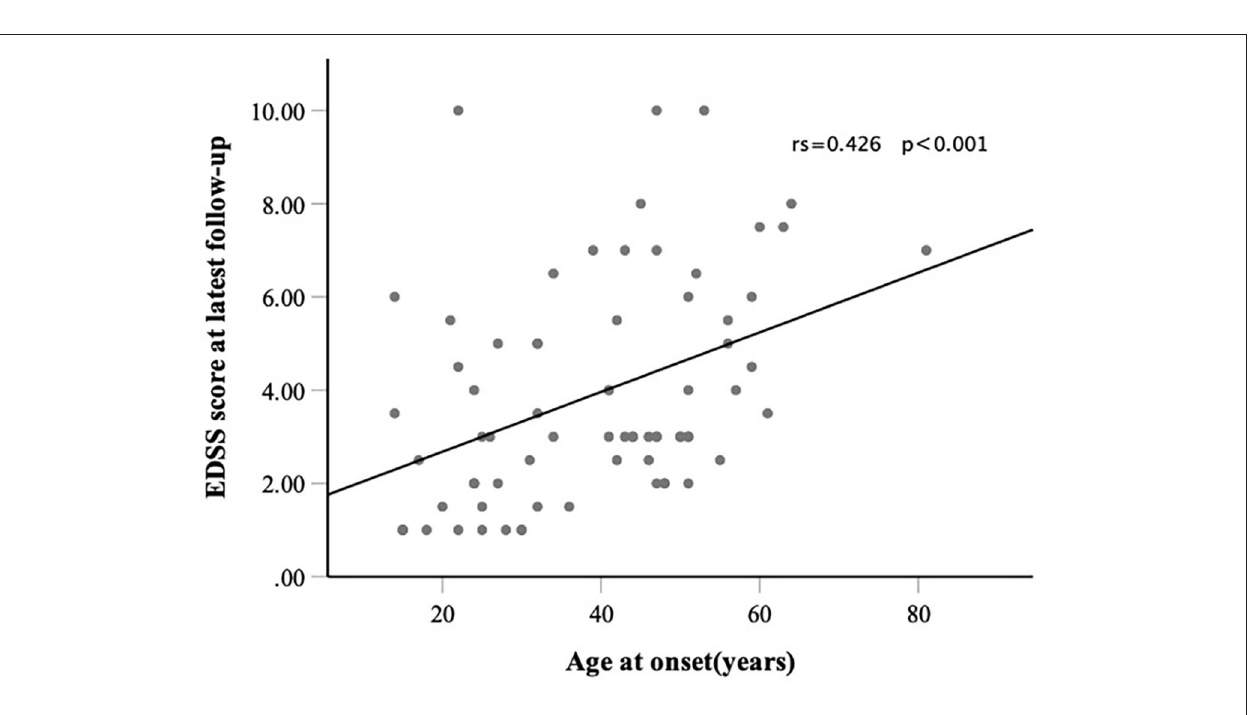
FIGURE 4 | Correlation between onset age and EDSS at the final follow-up time